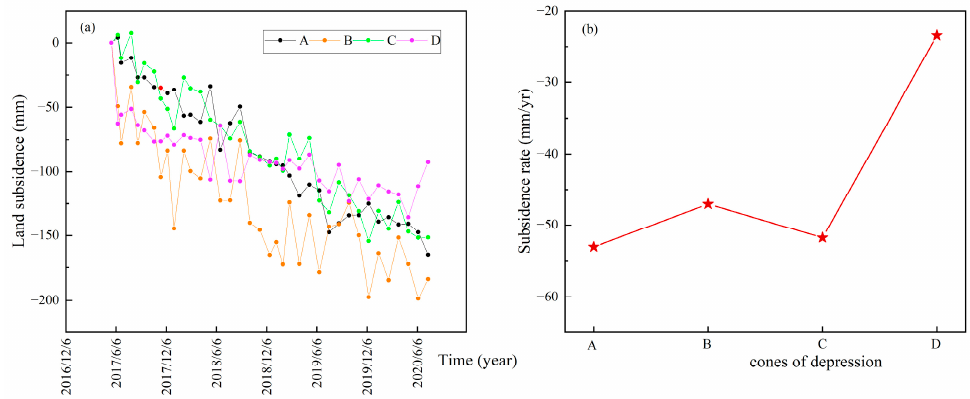
Figure 7. Subsidence sequences at four funnels from May 2017 to July 2020. ( a ) Cumulative subsidence; ( b ) Average subsidence rate.